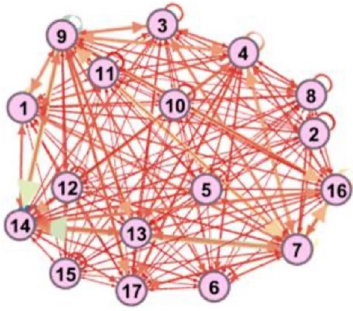
Figure 3. Matrix G